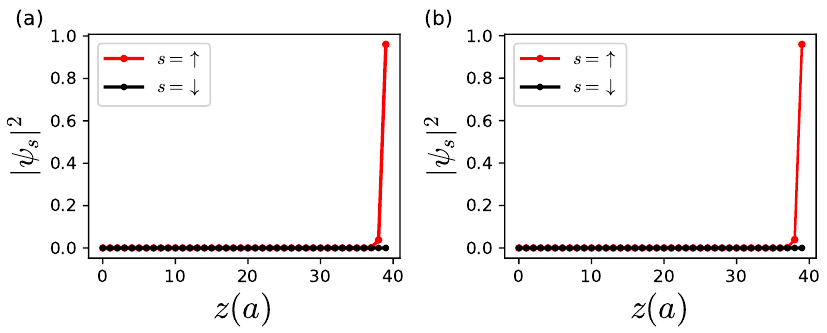
Figure 12: Eigenstate plots of the right moving Fermi arc surface states for the zero field ( B = 0) case for a finite slab along the z -direction with lattice sites L (a) This is in the LCI phase: the right moving surface states are localized on the top surface z = L and are polarized along z -direction with pseudospin s = ↑ . (b) This is z in the W2 phase: the right moving Fermi arc states are localized on the top surface z = L and they are polarized along z -direction with pseudospin s = ↑ . z z = L and they are polarized along the positive z -direction with pseudospin s = ↑ . In z